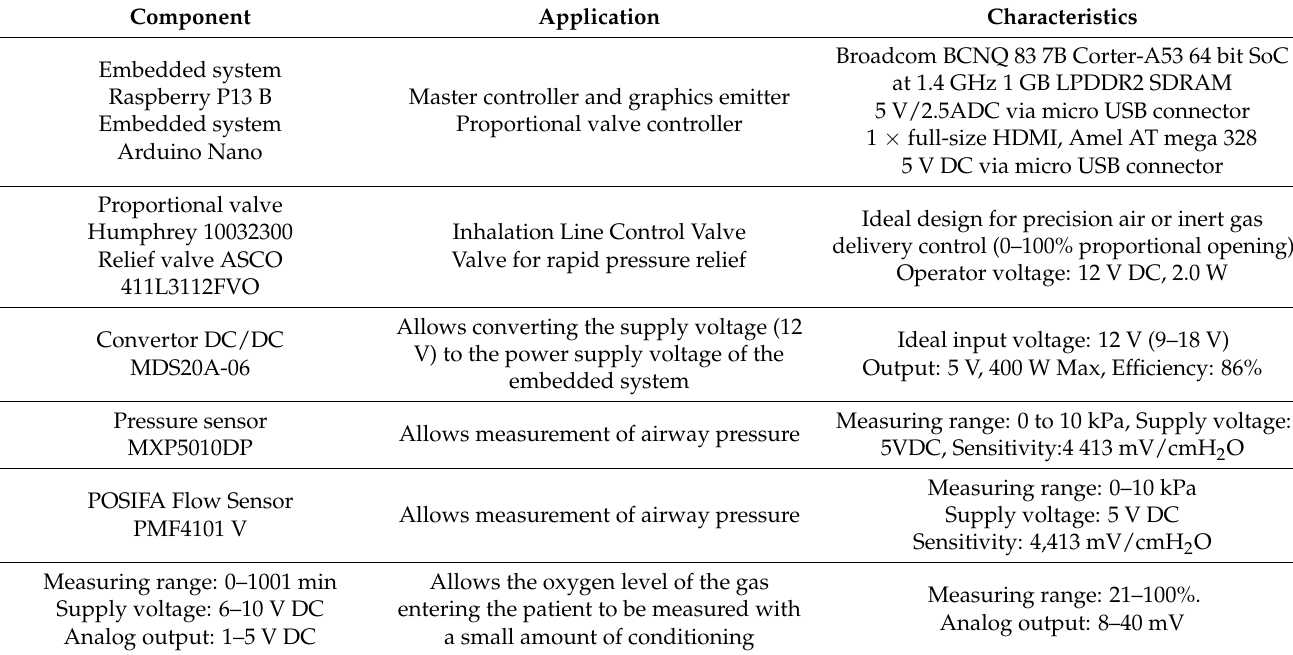
Table 3. Features of some components commonly used for mechanical ventilator